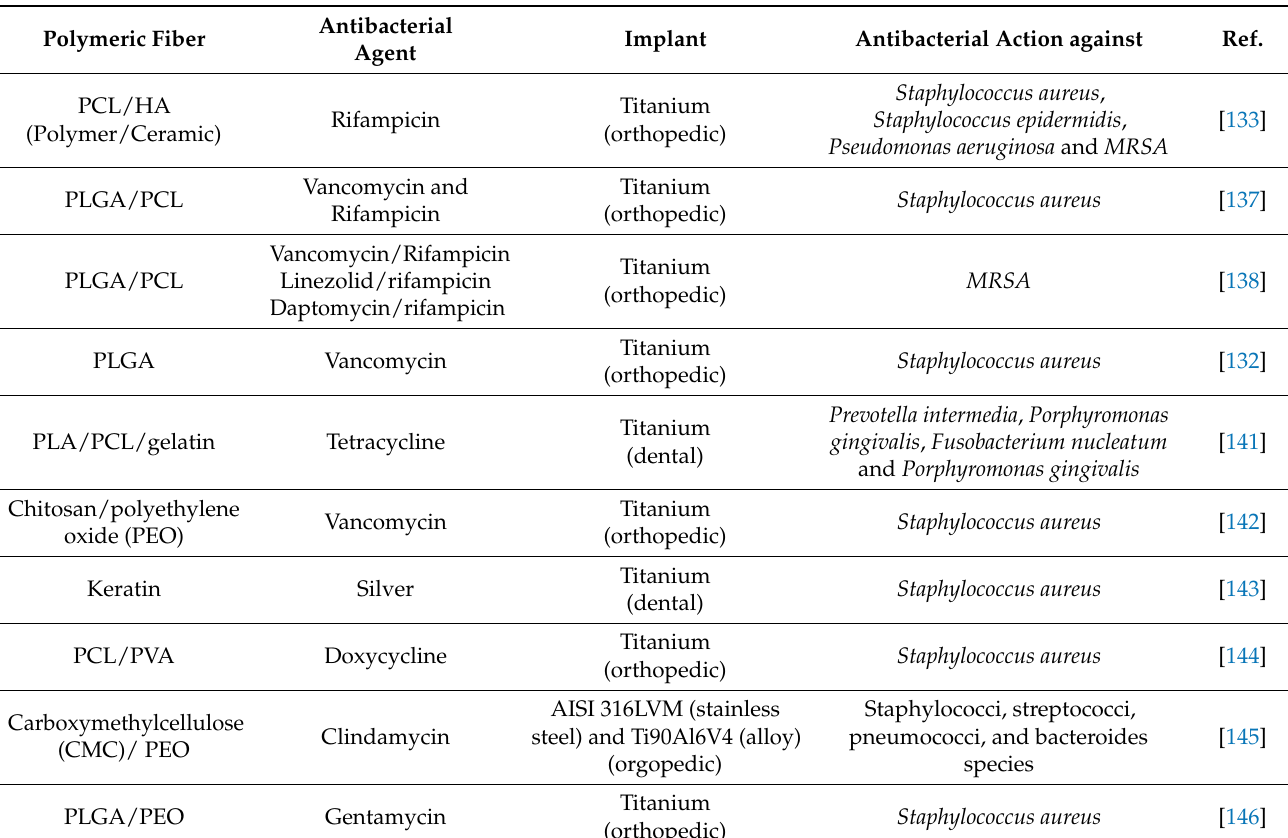
Table 3. Electrospun NF coatings for implant-related